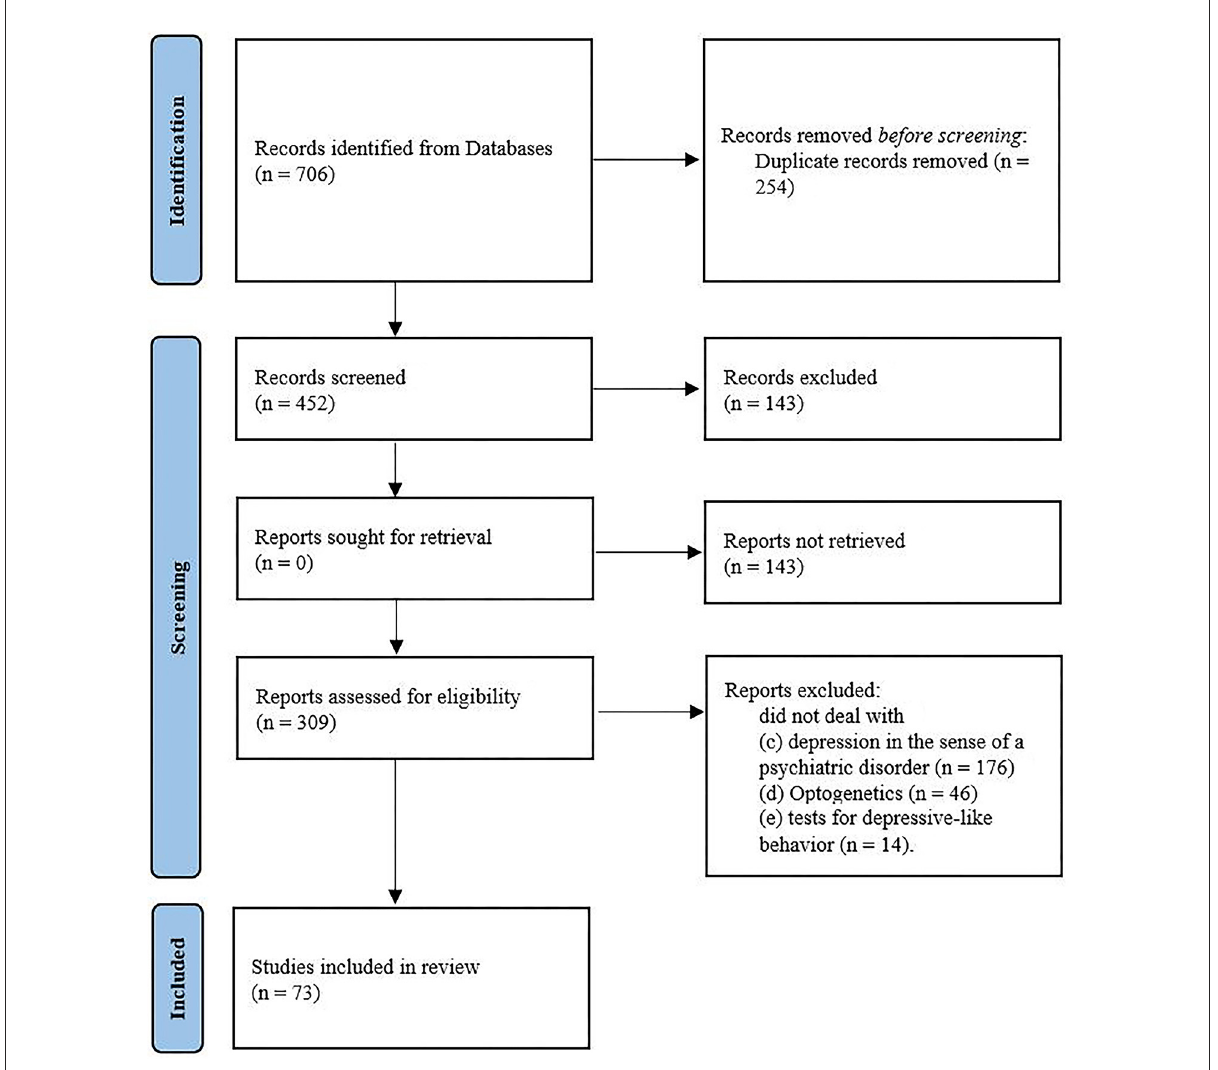
FIGURE1 Flow chart of study selection by systematic search process according to the PRISMA group (2020).